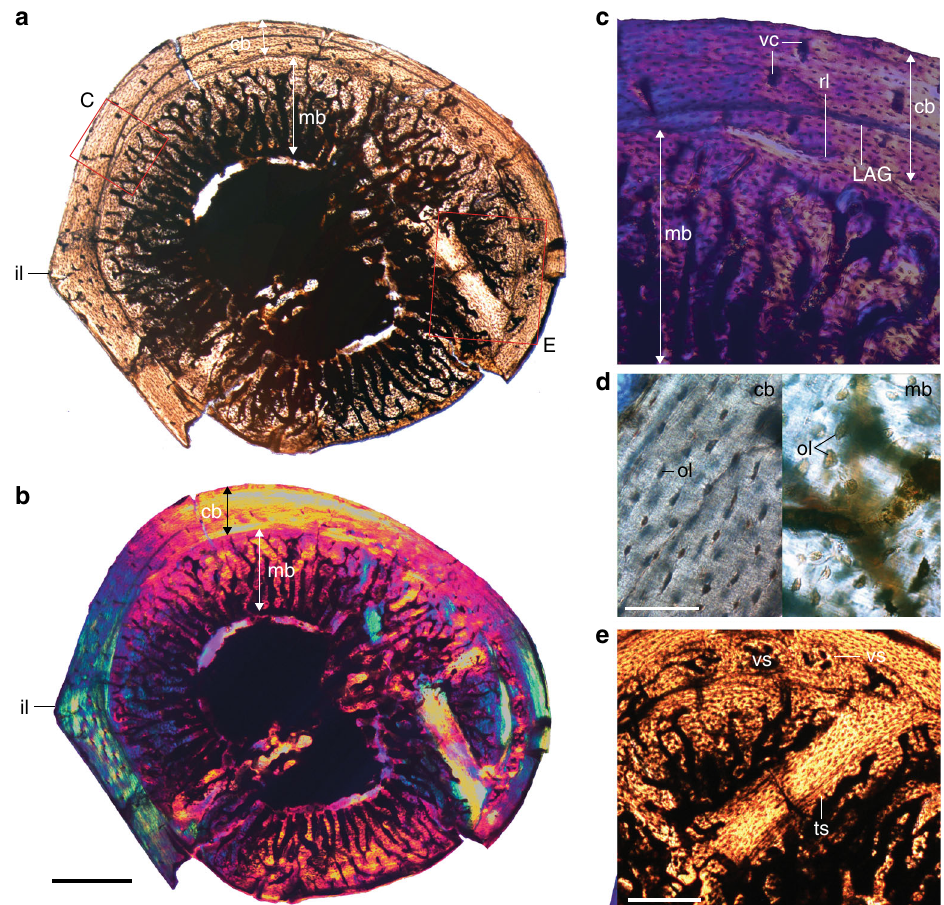
Fig. 2 Osteohistology of the femur of pengornithid IVPP V15576. a Full cross-section under normal light; b cross-section under polarized light; c LAG in femur approached by endosteal resorption; d close up of the osteocyte lacunae in the cortical bone compared to the larger and more irregular osteocyte lacunae in the medullary bone; e close up of region preserving vascular sinuses and a structure interpreted as a trabecula. Anatomical abbreviations: cb, cortical bone; il, intermuscular line; LAG, line of arrested growth; mb, medullary bone; ol, osteocyte lacunae; rl, resorption line; vc, vascular canal; vs, vascular sinus; ts, trabecular strut. Scale bar for a and b is 500 µ m; scale bar for d is 50 µ m; scale bar for e is 200 µ